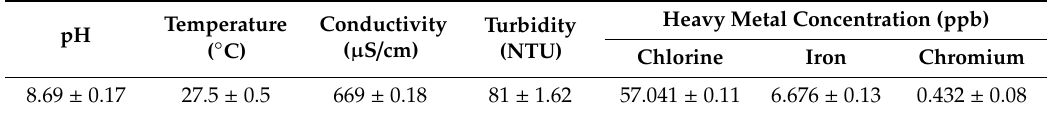
Table 3. Characteristics of the tap water used for testing filtration performance of the electro-spun membrane.